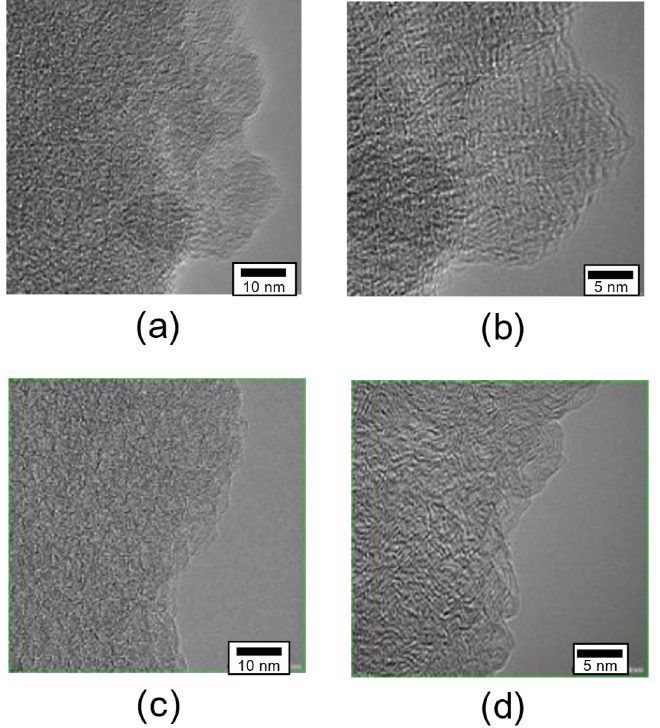
Figure 3. TEM images of the samples: ( a , b ) raw biochar; ( c , d ) biochar activated with 75 wt.% KOH. The CO 2 adsorption isotherms at 298 K of the raw biochar and the sample activated with 75 wt.% KOH are shown in Figure 4. The amount of adsorbed CO 2 increased after the KOH activation. The micropore size distribution was evaluated from these experimental data by using the Grand Canonical Monte Carlo (GCMC) method, and this is shown in Figure 5. Because the probe molecule is CO 2 , the effective range calculated from the CO 2 adsorption data until 1 atm is 0.32–1.4 nm. The results indicated that the micropores with an approximate width of 0.57 nm were increased by the KOH activation. This increment may be related to the intercalation of potassium between the carbon